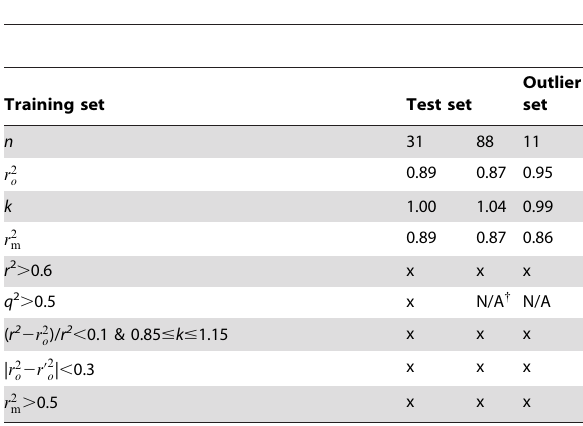
Table 3. Validation verification based on prediction performance of those molecules in the training set, test set and outlier